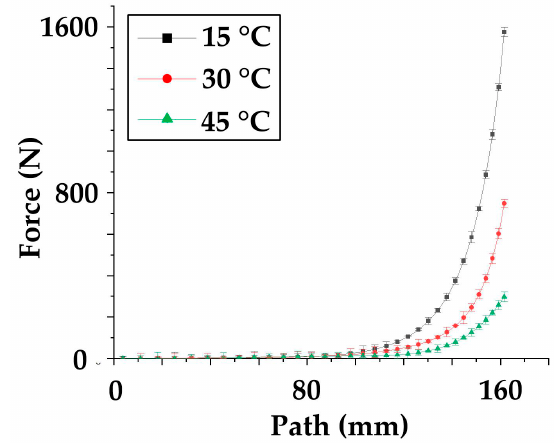
Figure 9. The axial tensile test curves.